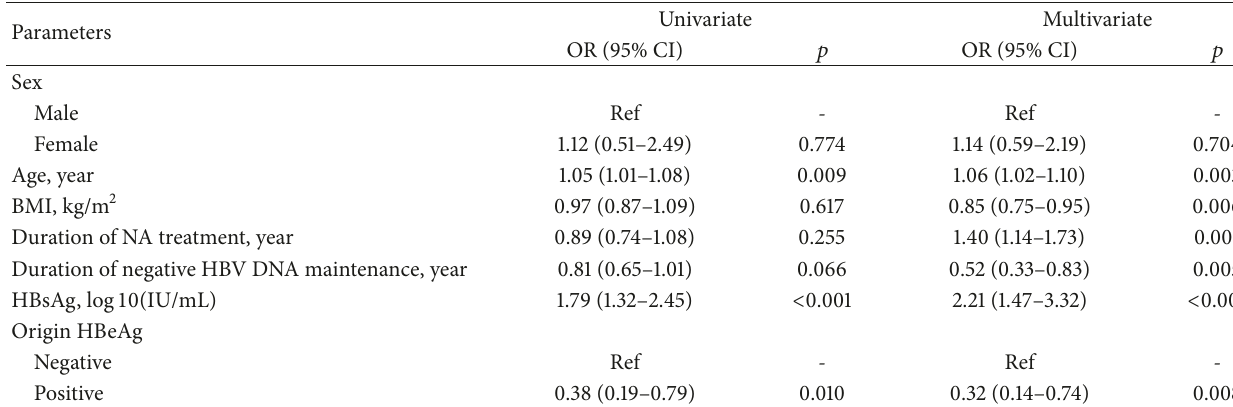
Figure 2: Change of levels of ALT and HBV DNA in four categories from 0 to 48 weeks. Table 2: Independent variables associated with virologic relapse in GEE